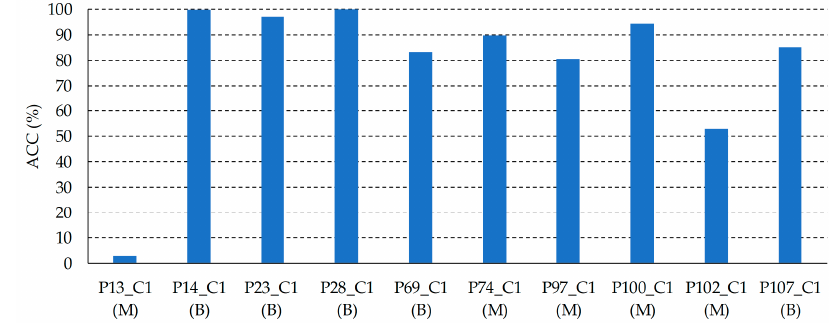
Figure 16. Test classification 𝐴𝐶𝐶 results obtained with the SVM Linear classifier. Below each patient ID, the correct diagnosis of the PSL is presented. B: Benign; M: Malignant.